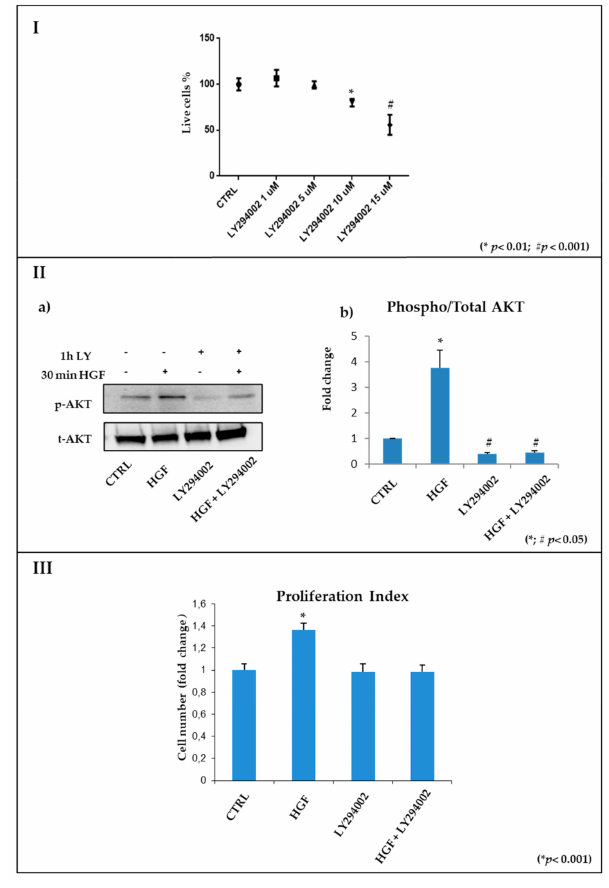
Figure 2. ( I ) Cell death Flow Cytometry nalysis. Graphical representation of the percentage of live cells obtained by culturing NT2D1 cells with di ff erent concentrations of LY294002 for 48 h (* p < 0.01; # p < 0.001). ( II ) Western blot analyses of p-AKT and total AKT in NT2D1 cell lines cultured in basal conditions (CTRL), with 5 µ M LY294002, with 40 ng / mL HGF, and with LY294002 + HGF. On the left: representative images of p-AKT and total AKT bands, obtained by using stain-free technology (Bio-Rad Laboratories Inc., Hercules, CA, USA), are shown. On the right: the densitometric analysis of pAKT / AKT bands is reported (*; # p < 0.05). ( III ) Graphical representation of the number of NT2D1 cells cultured for 48 h in control conditions, with HGF, with LY294002, or their combination. Cells cultured with HGF had a high proliferative rate (* p < 0.001). Results were expressed in fold change, with the control considered as 1 ( ± standard error of the mean